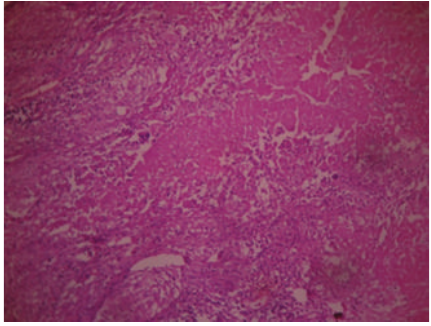
Figure 4: Microscopic picture shows features of caseating granulo- matous inflammation.